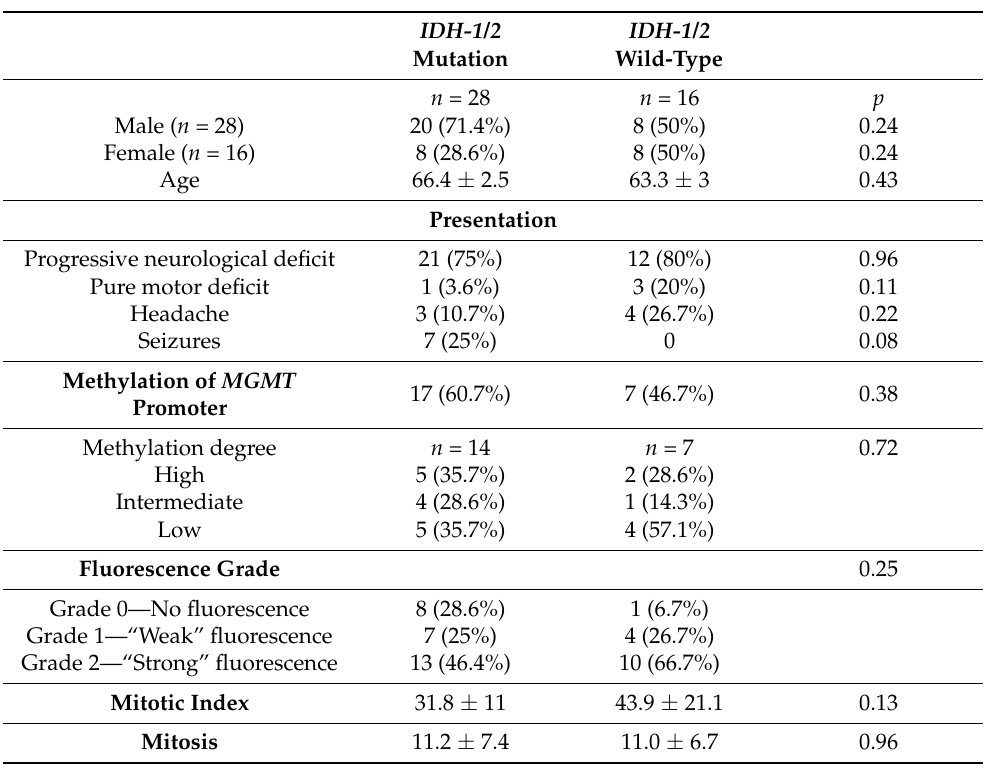
Table 1. Descriptive results.